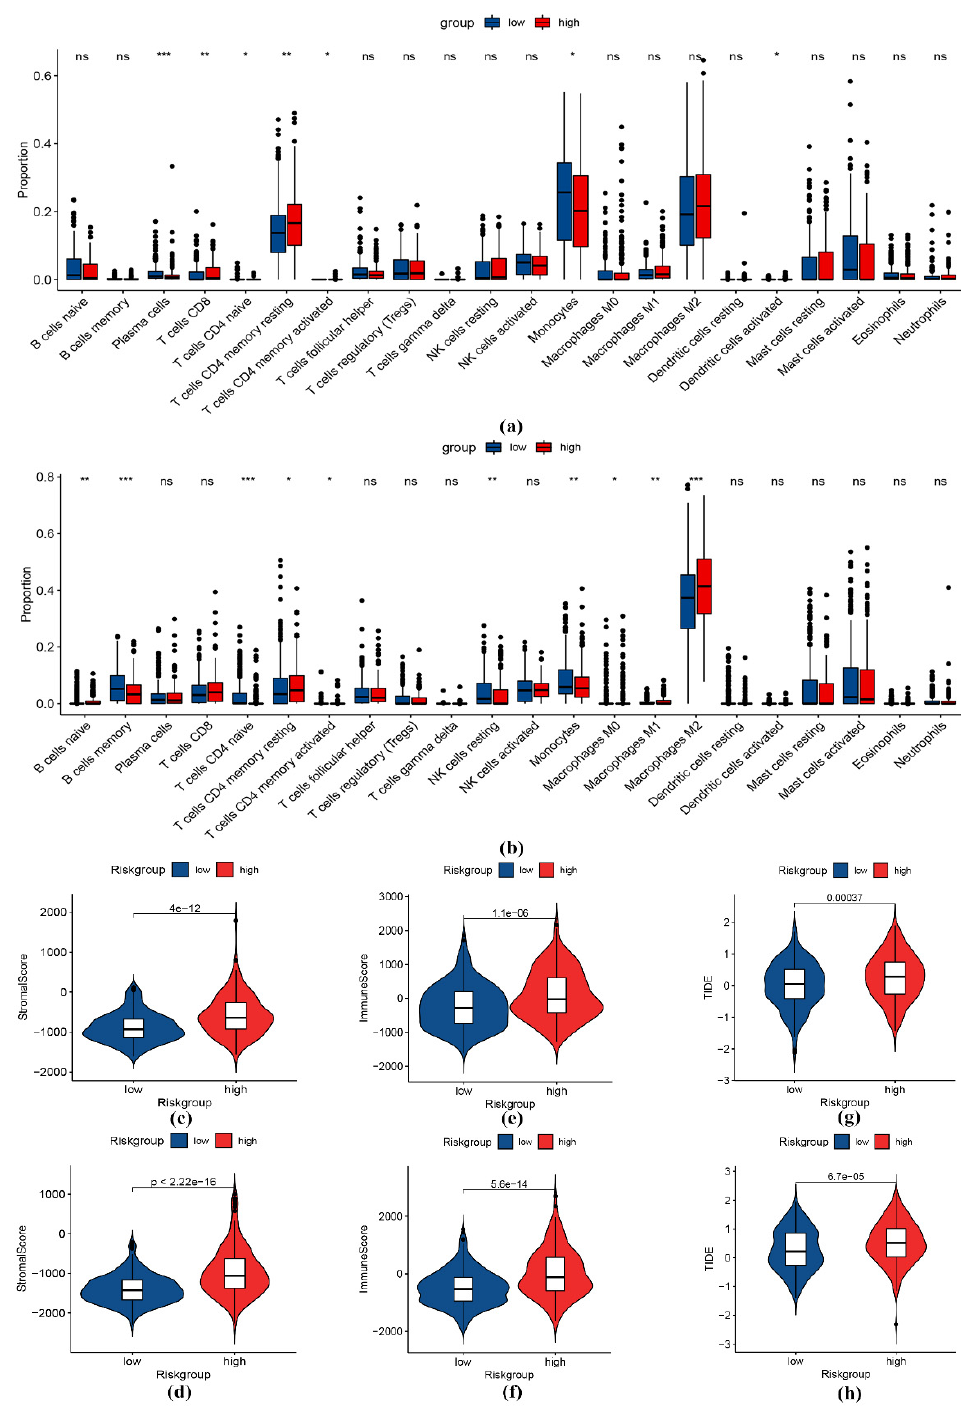
Figure 6. Immune profile analysis between the risk groups. Immune infiltration analysis in the TCGA ( a ) and CGGA ( b ) cohorts. Comparison of the stromal score ( c ), immune score ( e ), and TIDE score ( g ) in the TCGA cohort. Comparison of the stromal score ( d ), immune score ( f ), and TIDE score ( h ) in the CGGA cohort. * represents p < 0.05; ** represents p < 0.01; *** represents p < 0.001.